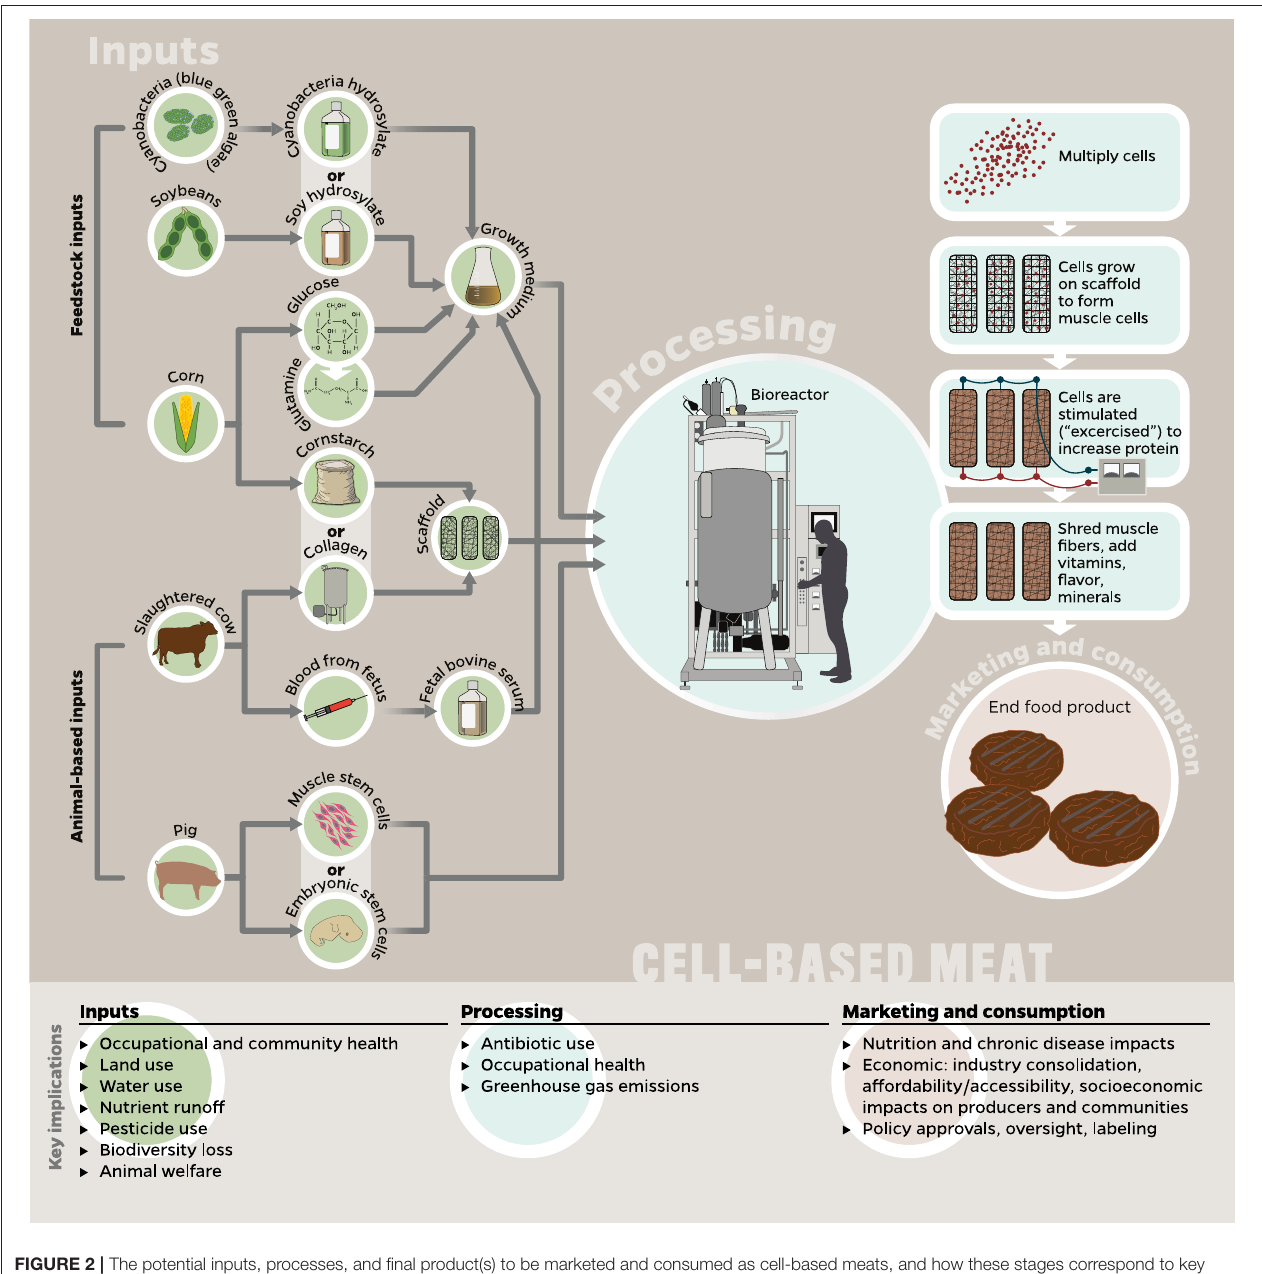
FIGURE 2 | The potential inputs, processes, and final product(s) to be marketed and consumed as cell-based meats, and how these stages correspond to key implications explored in this paper. Many of the implications listed here are applicable to multiple stages, e.g., GHG emissions occur in the production of inputs, processing, and retail/consumer stages; however, we listed each implication only with the stage to which it is most relevant or has the greatest potential impact. Since no products are currently available on the market, the figure was designed by the authors using hypothetical inputs proposed by Tuomisto and Teixeira de Mattos (2011) and Mattick et al. (2015b) as well as currently required animal-based inputs (e.g., fetal bovine serum, collagen-based scaffolds) (Stephens et al., 2018; Thorrez and Vandenburgh, 2019), although we recognize the goal to eliminate the latter eventually.